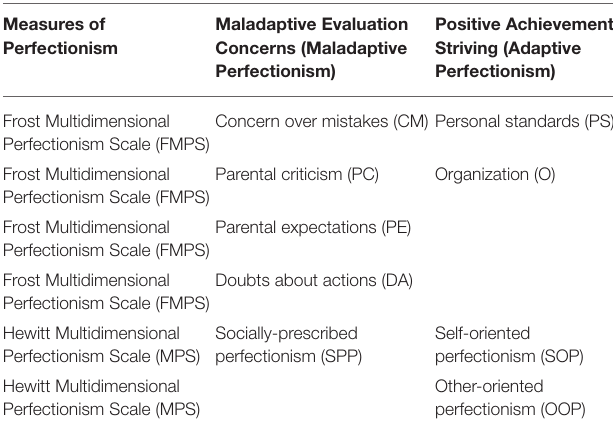
TABLE 1 | Two main factors of perfectionism (23,